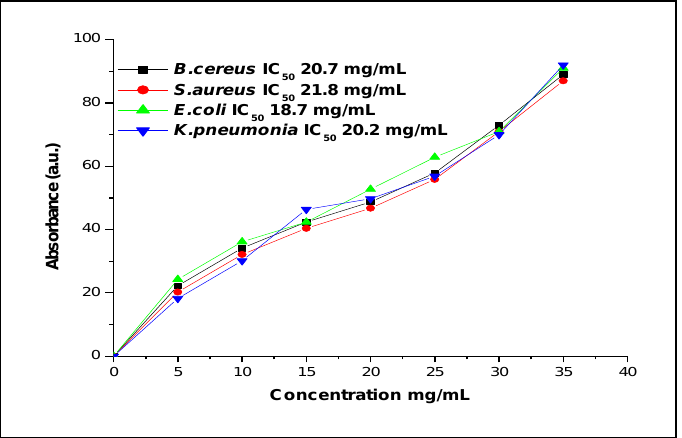
Figure 9. Graph showing antibacterial potential of okra extract against S. aureus (21.8 mg/mL), E. coli (18.7 mg/mL), B. cereus (20.7 mg/mL), and K. pneumoniae (20.2 mg/mL). The experiment was performed in triplicate, and the results are expressed as mean ± standard deviation.